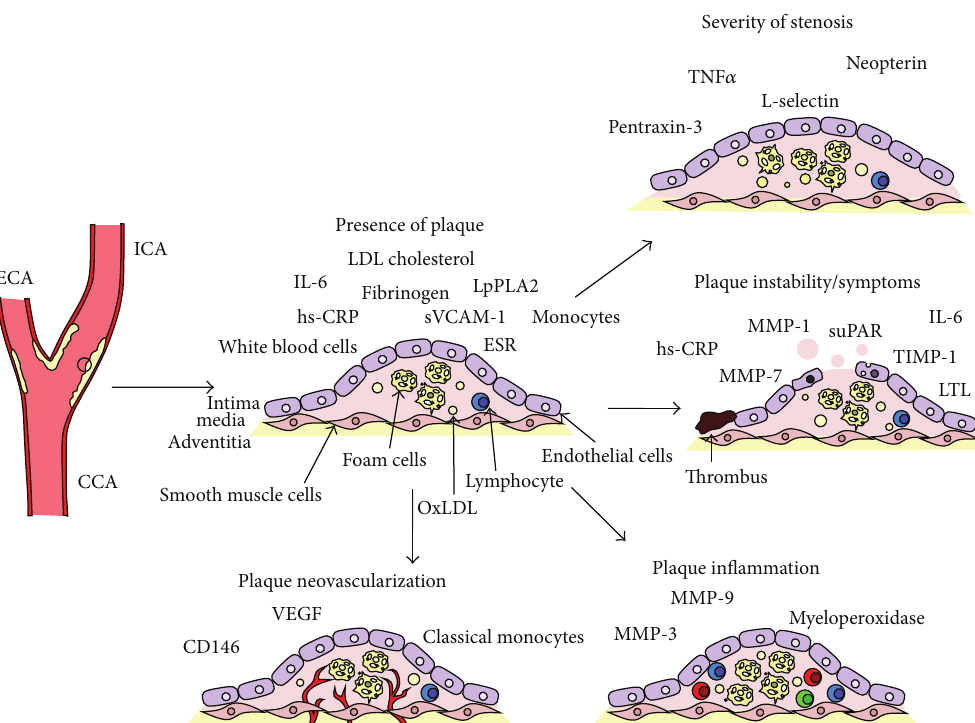
Figure 1: Summary of the main biomarkers associated with different stages and manifestation of carotid atherosclerosis. CCA: common carotid artery; ICA: internal carotid artery; ECA: external carotid artery; IL: interleukin; LDL: low-density lipoprotein; OxLDL: oxidized low- densitylipoprotein;ESR:erythrocytesedimentationrate;hs-CRP:highsensitivityC-reactiveprotein;sVCAM-1:solublevascularcelladhesion molecule 1; LpPLA2: lipoprotein-associated phospholipase A2; TNF- 𝛼 : tumour necrosis factor alpha; MMP: matrix metalloproteinase; TIMP- 1: tissue inhibitor of matrix proteinases; suPAR: soluble urokinase plasminogen activator receptor; LTL: leukocyte telomere length; VEGF: vascular endothelial growth